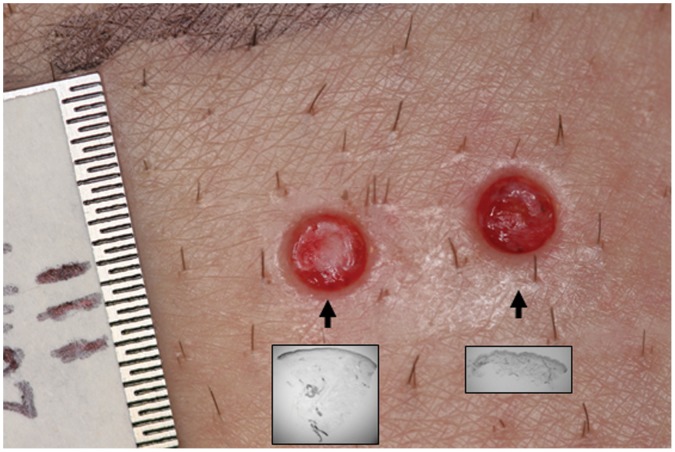
Skin biopsies as a model of wound healing.Three millimeter punch skin biopsies from the thigh with a ruler used as an internal standard measurement. The shallow biopsy (shown in subset) on the right contains pieces of hair follicles seen within the wound bed. The deep biopsy (shown in subset) is on the left and contains no remnants of adnexal structures within the wound bed.